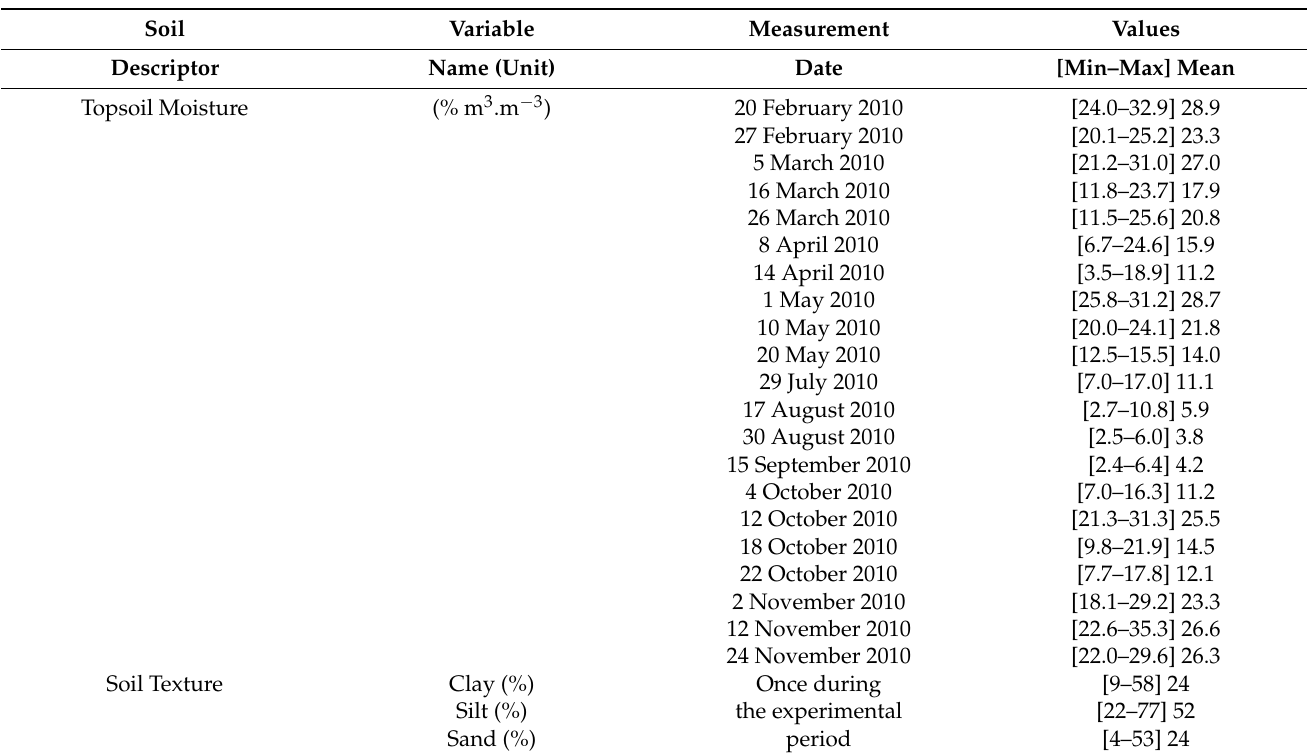
Table 1. Overview of the measurements collected on the network of plots. Surface roughness is divided into perpendicular ( ├ ) and parallel (||) measurements compared to the row direction.